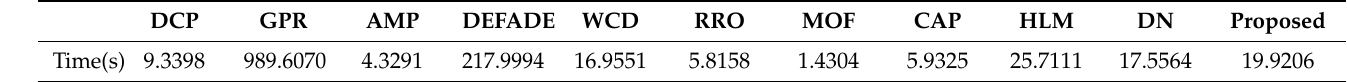
Table 4. The average processing time of 100 hazy remote sensing